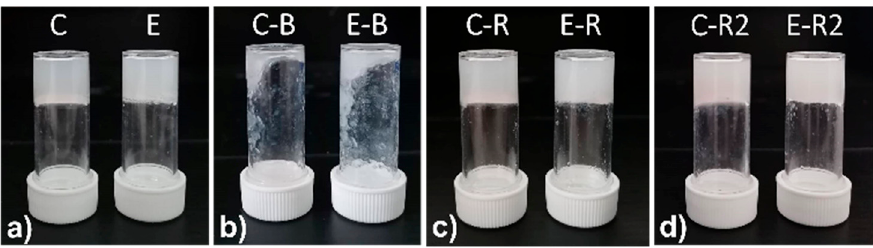
Figure 2. Thixotropy tests of samples C and E . From left to right: ( a ) samples after formation ( C , E ), ( b ) samples after break ( C ‐ B , E ‐ B ), ( c ) samples after overnight recovery ( C ‐ R , E ‐ R ), ( d ) samples after being shaken and reformed a second time ( C ‐ R2 , E ‐ R2 ).